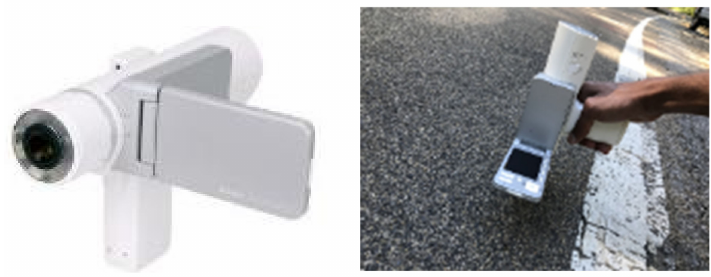
Figure 8. ShuttlePix microscopic imaging camera.